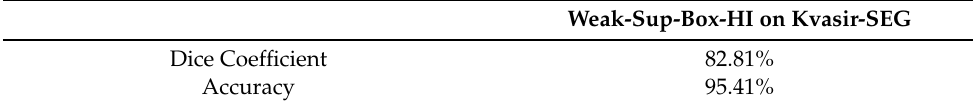
Table 7. Test-set scores on Kvasir-SEG from the Weak-Sup-Box-HI